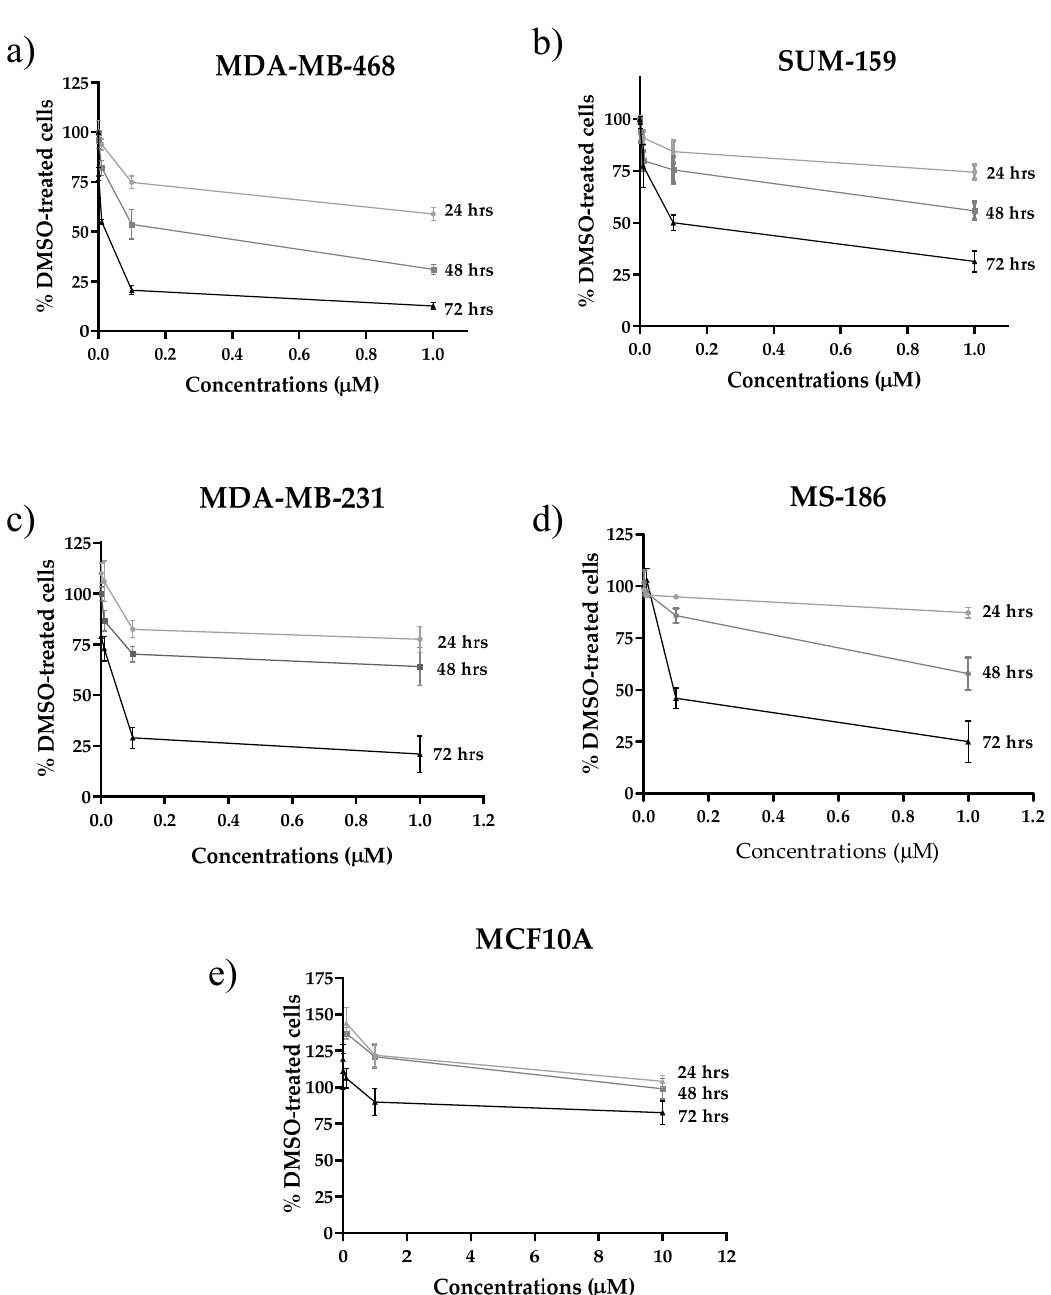
Figure 2. Cytotoxic activity of selinexor in TNBC and normal breast epithelial cell lines. ( a ) SUM-159, ( b ) MDA-MB-468, ( c ) MDA-MB-231, ( d ) MS-186, and ( e ) MCF10A cells were treated for 24, 48, and 72 h with increasing concentrations of selinexor and the cytotoxic activity was assessed by means of MTS assay. Data are expressed as mean ± SD of at least three independent experiments.